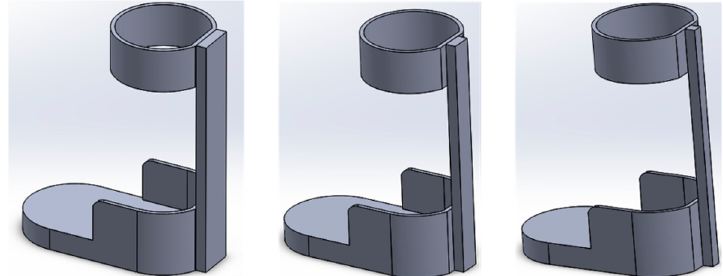
Figure 5. AFOs with different manufactured strut widths. From the left to right—stiffness of 130%, 100%, and 50%, respectively [61].